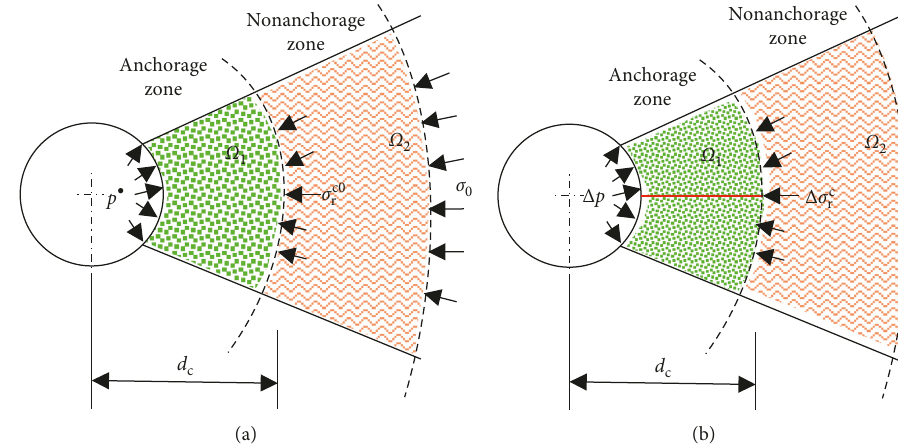
Figure 4: Decomposition for analysis model of anchorage roadway. (a) Initial state model. (b) Incremental